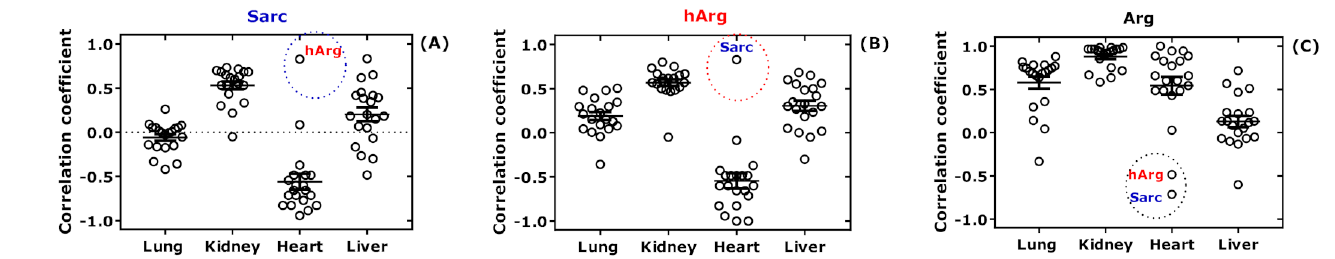
Figure 10. Spearman correlation coefficients for free tissue Sarc ( A ), hArg ( B ), and Arg ( C ) versus the other free tissue amino acids in lung, kidney, heart, and liver of the study rats. The complete set of the results are found in Figure S2. All amino acids are represented by a symbol. The data points for Sarc and hArg are encircled.